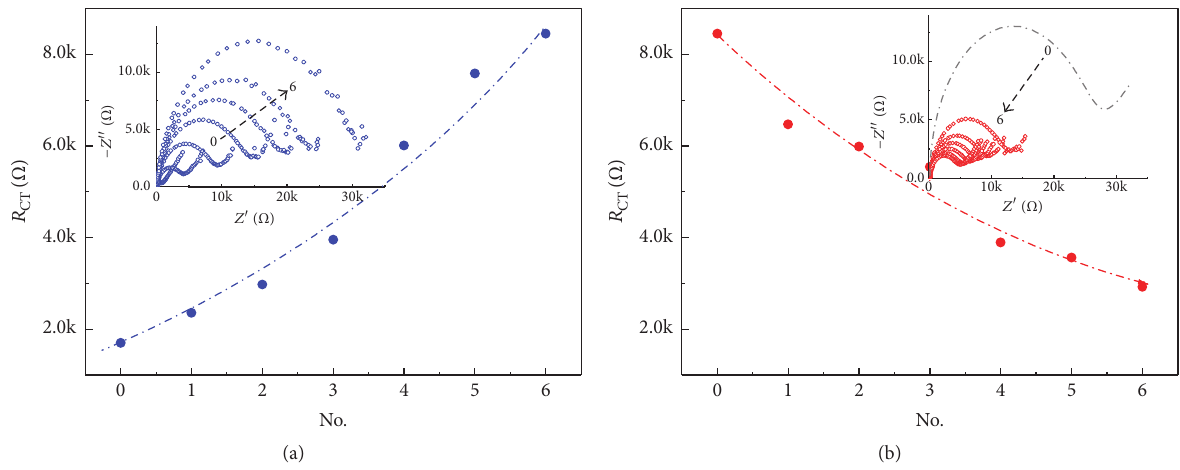
Figure 3: Correlations of the 𝑅 CT resolved from the Nyquist plots inset in each panel for 1mM of Fe ( CN ) 63−/4− on HOPG with the number of repetitions (No.) of the electrode being treated with 1mM APBA (a) and further with 1mM of Ru(bpy) 2 (phendione) 2+ (b).